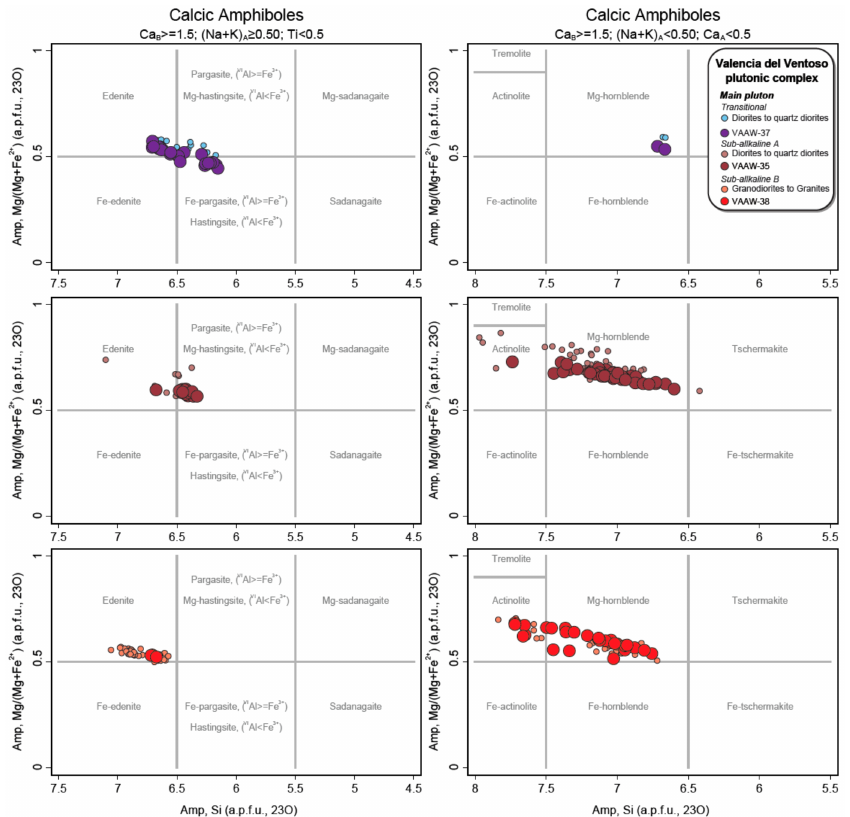
Figure 3. Classification of amphiboles from intermediate and border facies rocks from the Valencia del Ventoso main pluton following the criteria proposed by [49]. Compositional data of amphibole from [44] (smaller lighter symbols) are shown for